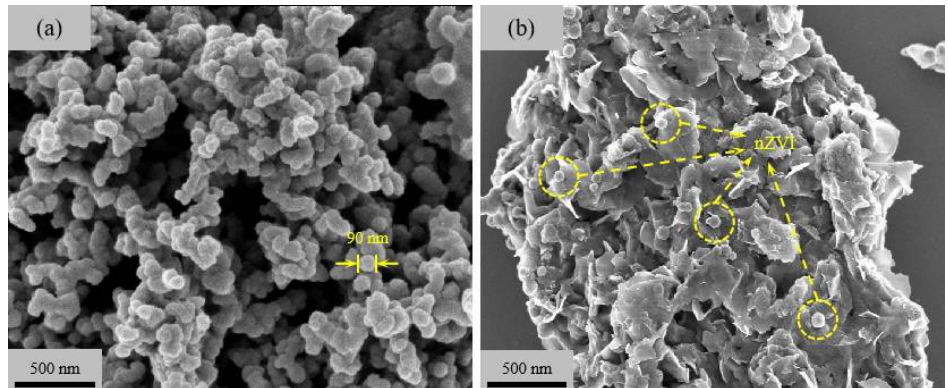
Figure 2. SEM images of ( a ) nZVI and ( b ) nZVI@H. Table 1. The BET surface area of hydrotalcite, nZVI and nZVI@H. Sample